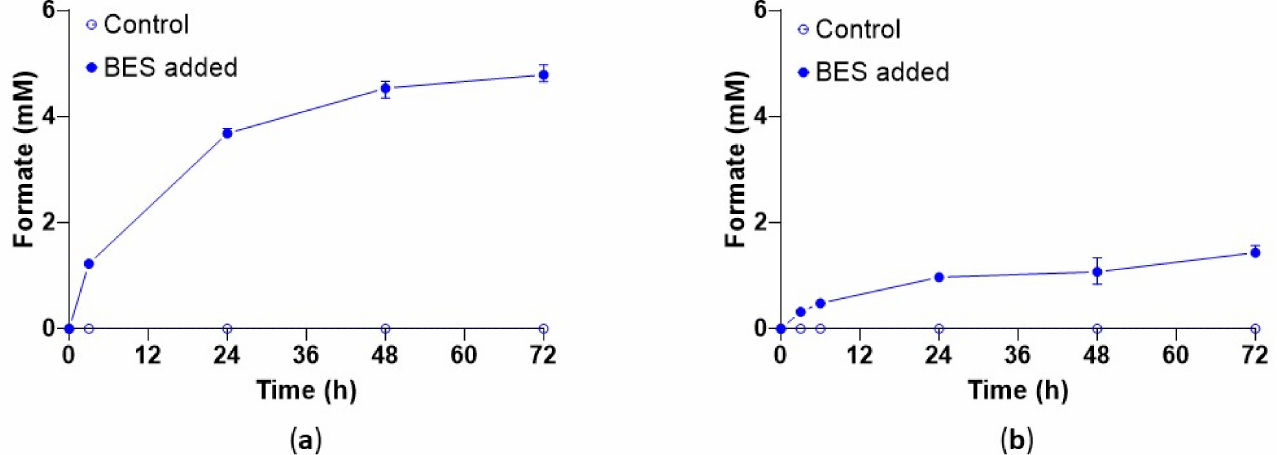
Figure 4. Response of the hydrogenotrophic methanogenic strains Methanococcus maripaludis ( a ) and Methanobacterium formicicum ( b ) to BES (50 mM) in medium C. The cultures were pressurized with H 2 (80%) and CO 2 at ~2.2 bar. The error bars depict the standard deviation of the mean of n = 5 ( a ) and n = 4 ( b